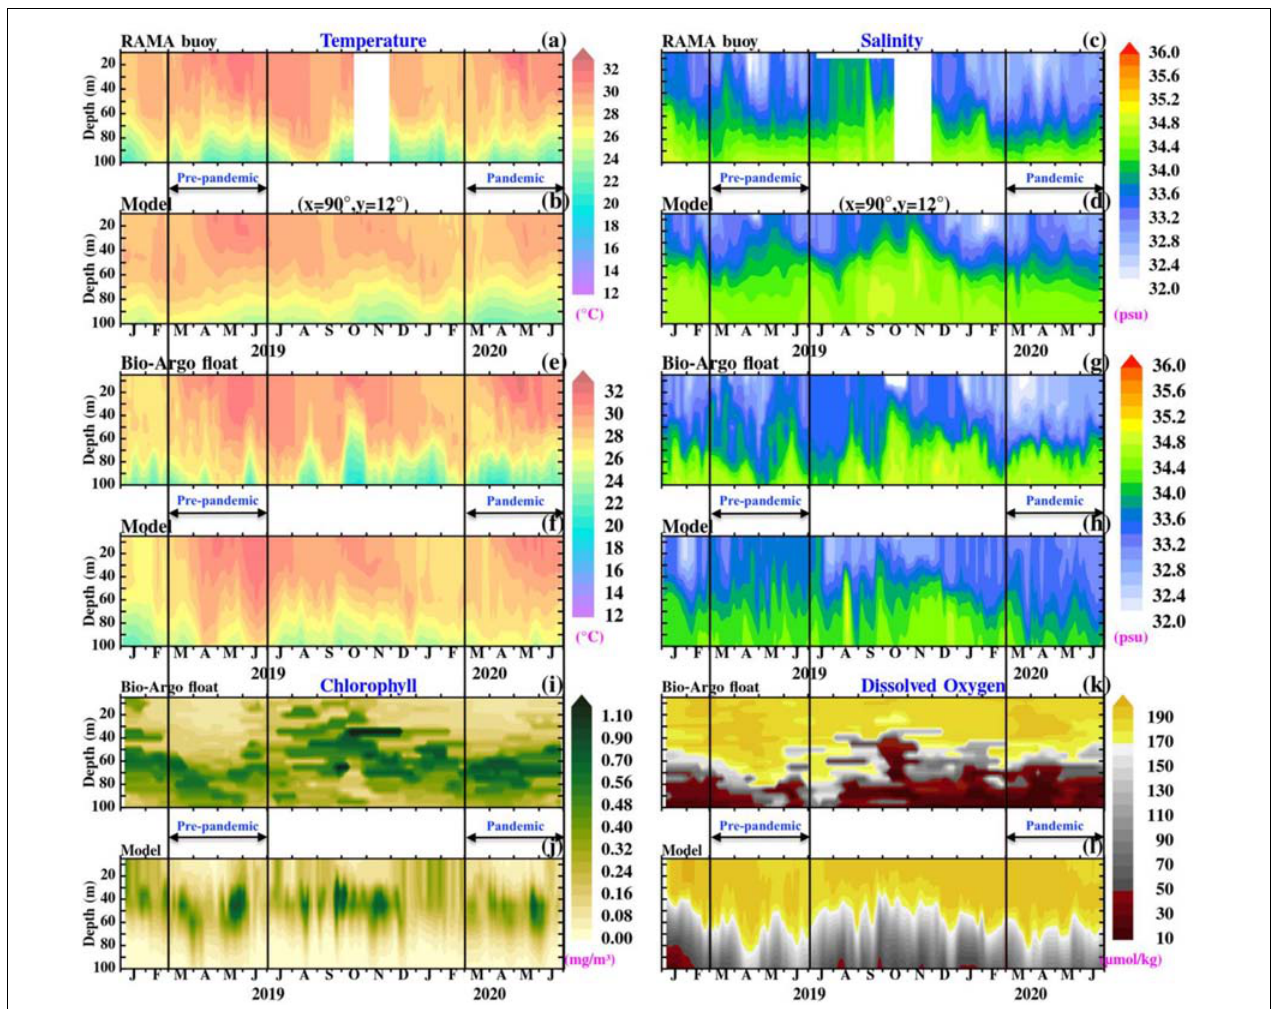
FIGURE 4 | Time-depth section of temperature and salinity from RAMA buoy location at 90 ◦ E, 12 ◦ N (A,C) in the BoB compared with model-simulated temperature and salinity over the same location (B,D) . The observed temperature, salinity, Chl-a concentration, and dissolved Oxygen (E,G,I,K) from the Bio-Argo float (WMO ID. 2902264) in the central BoB compared with the model-simulated parameters along the trajectory of float (F,H,J,L)